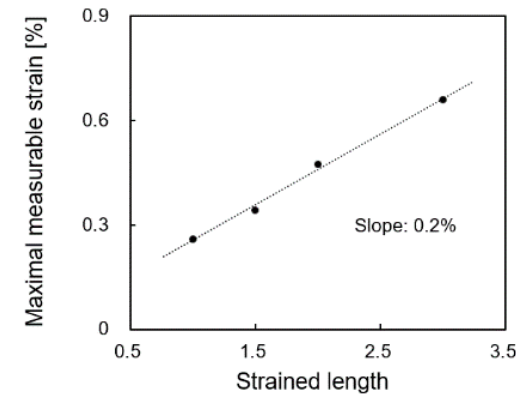
Figure 5. Maximal measurable strain plotted as a function of strained length L ε . The dotted line is a linear